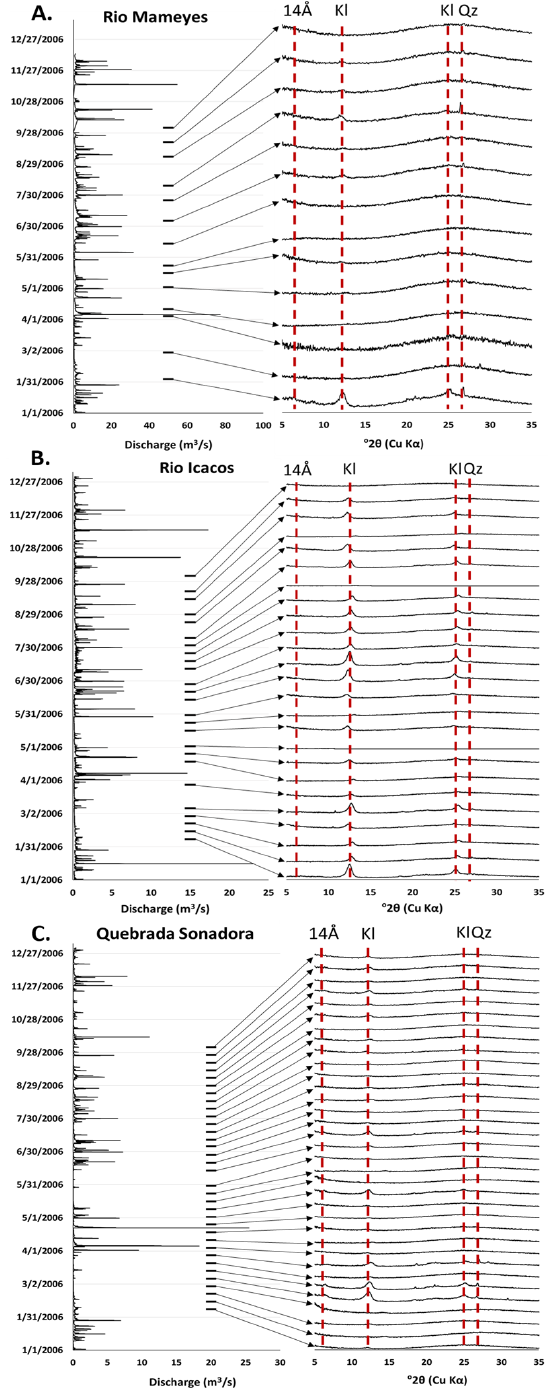
Figure 4. Hydrographs and X-ray diffractograms for Rio Mameyes ( A ), Rio Icacos ( B ) and Quebrada Sonadora ( C ). XRD Diffractograms of suspended sediment samples on filters are ordered by sample collection date (connected with arrows, date format: MM/DD/YYYY) red dashed lines indicate the main mineral peaks. Date labels by the diffractograms identify diffractograms mentioned in the text Section 3.3. Mineral abbreviations (14Å: chlorite-like, Kln: kaolinite, Qz: quartz) are from Warr [41].